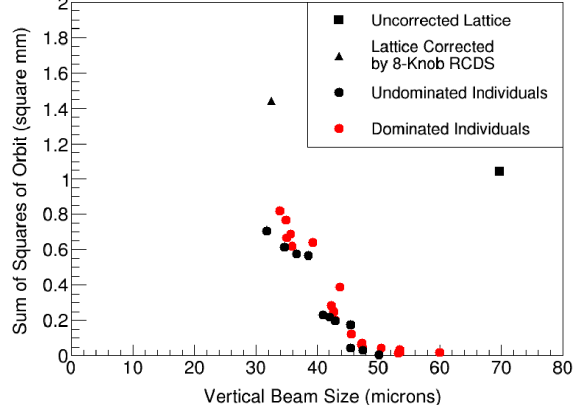
FIG. 8. The final generation of our genetic algorithm as applied to CESR, with the nondominated individuals differentiated from the rest. Also plotted are the initial beam size and orbit and those obtained after the 8-knob RCDS tuning, as in Fig. 5. The BPMs near the undulator had some offsets, so we are in fact attempting to steer the beam onto an arbitrary off-axis trajectory. Given that steering the beam onto a specific nonzero orbit also represents a trade-off with respect to minimizing emittance, our conclusions are not